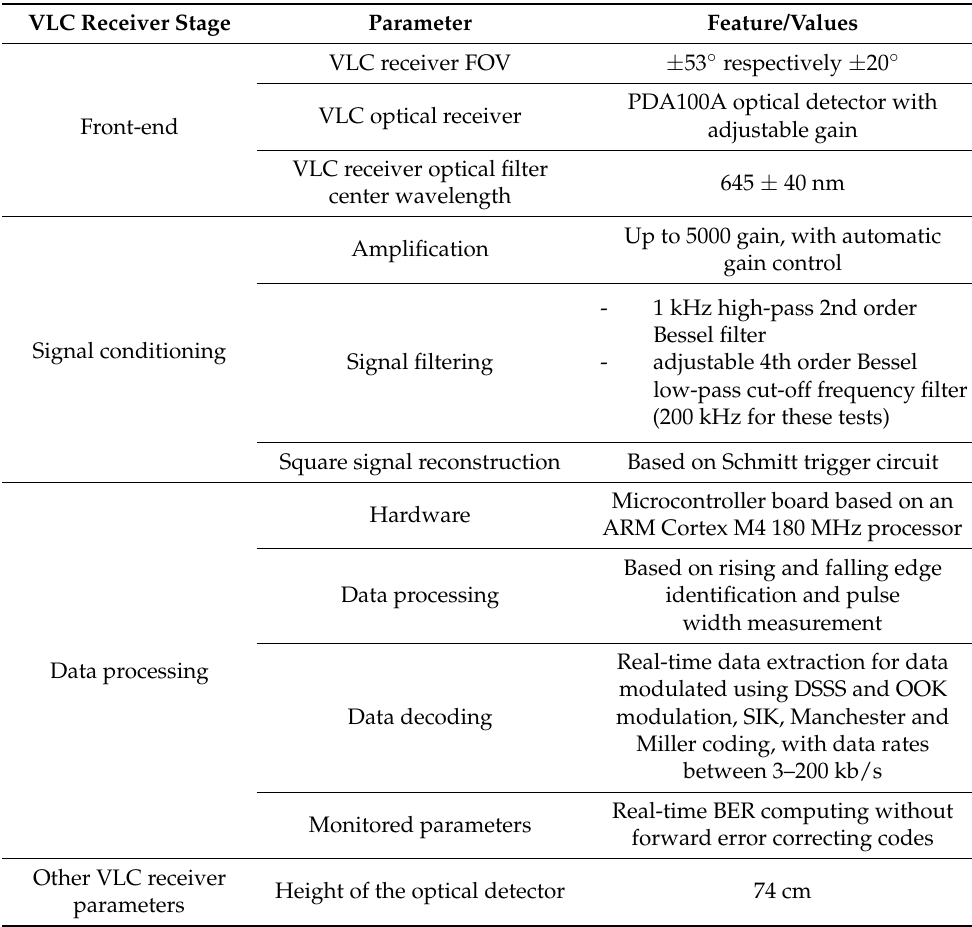
Table 2. Summary of the VLC receiver